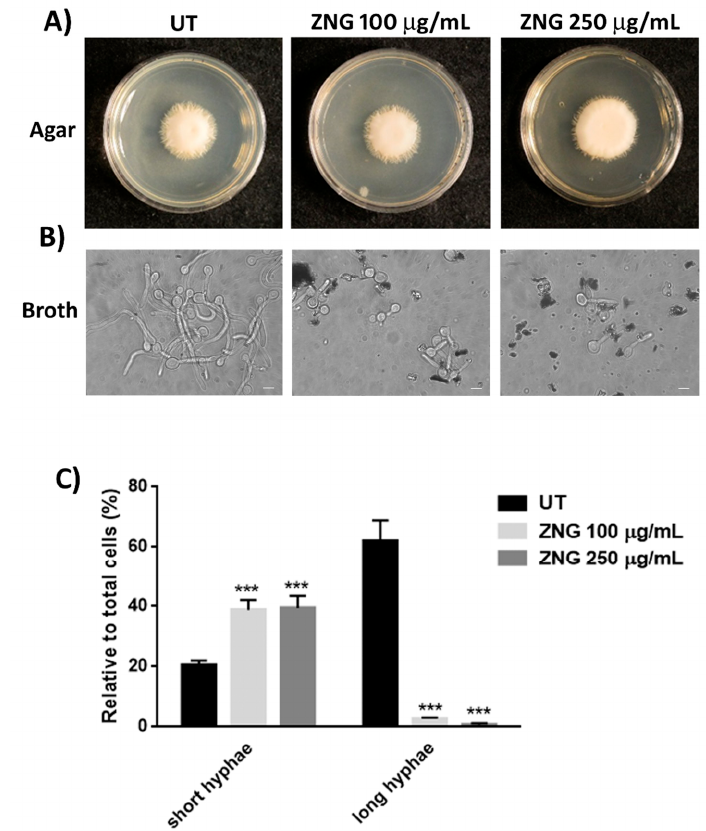
Figure 4. Inhibition of hyphal formation by ZNGs. ( A ) Effect of 100 µg/mL and 250 µg/mL ZNGs on C. albicans hyphal elongation on solid Spider medium. Plates were incubated at 37 °C for five days; ( B ) ZNGs activity on C. albicans hyphal formation in liquid Spider medium for 2.5 h at 37 °C. Scale bar 5 µm; and, ( C ) Percentage of short and long hyphae observed after 2.5 h of treatment with ZNGs. Untreated cells (UT) were used as control. A two-way ANOVA analysis with the Bonferroni post-test was used to assess the statistical significance (*** p < 0.001 with respect to untreated